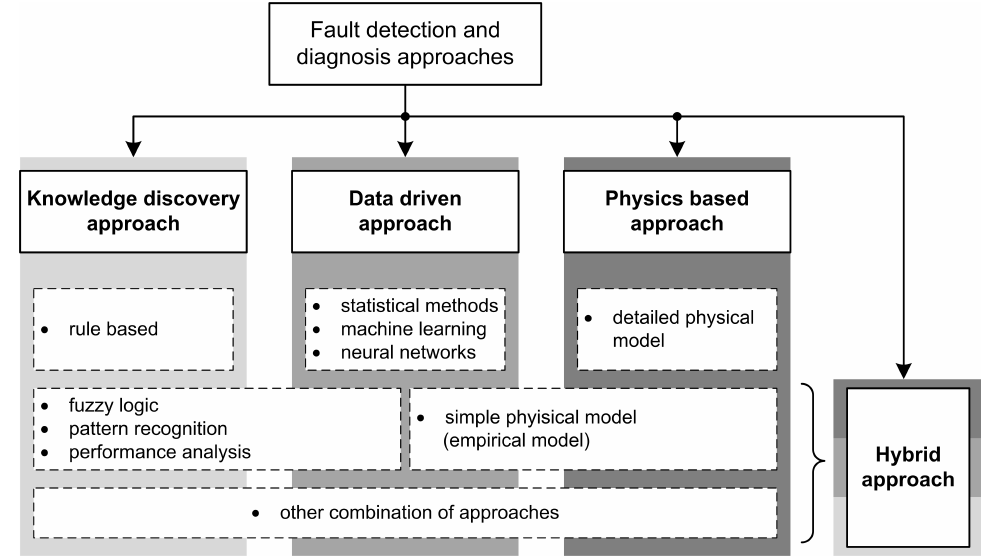
Figure 5. The proposed classification of FDD approaches in HVAC